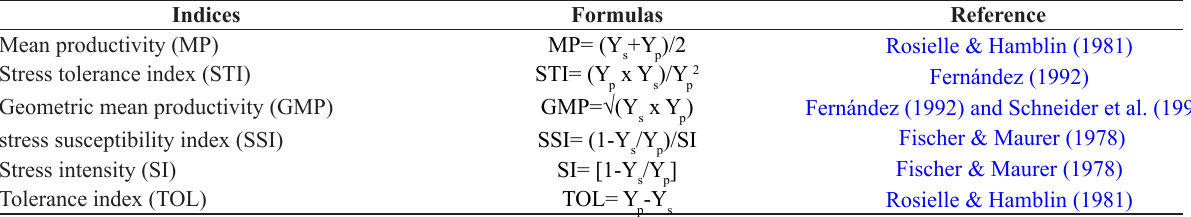
Table 2. Tolerance stress indices and their